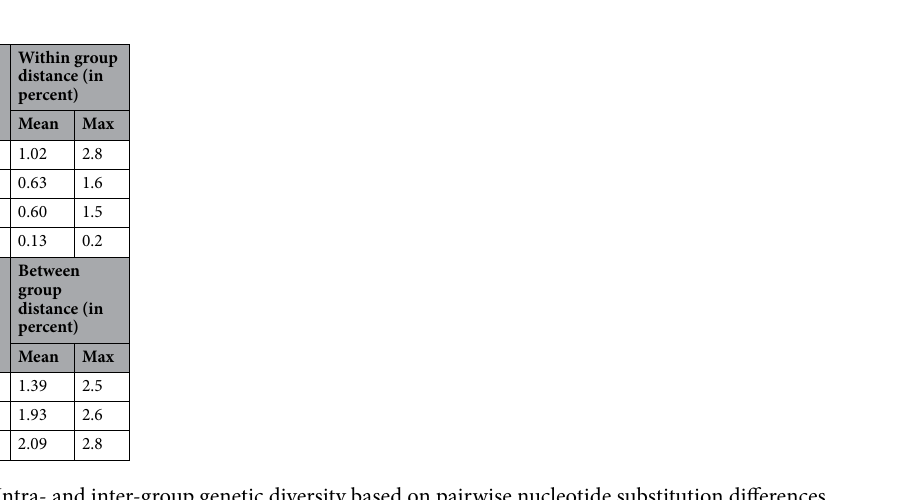
Table 2. Intra- and inter-group genetic diversity based on pairwise nucleotide substitution differences.